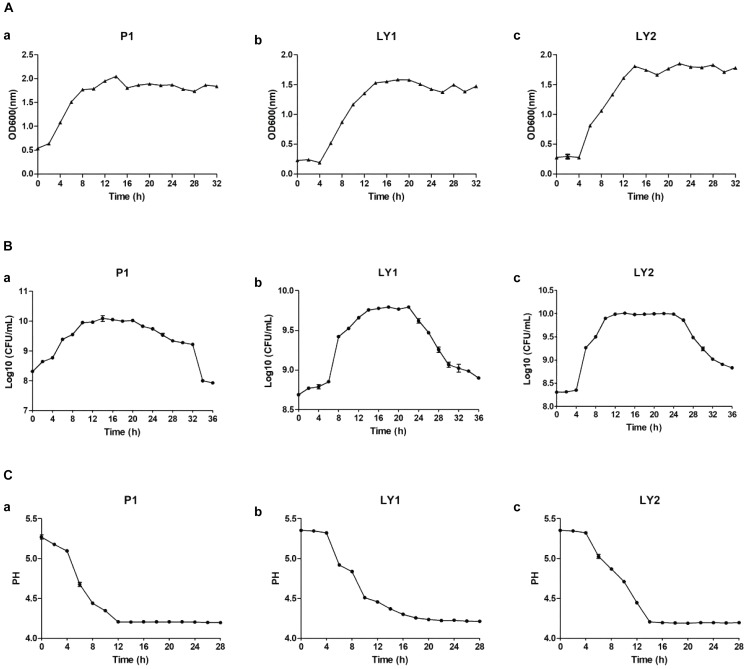
Measurement of OD600 values, colony-forming units and pH. (A) OD600 values measured every 2 h for a total of 32 h. (a) P1. (b) LY1. (c) LY2. (B) The colony-forming units were analyzed every 2 h for a total of 32 h, and the number of colonies was calculated as the log10 value of CFU per milliliter. (a) P1. (b) LY1. (c) LY2. (C) pH measurements taken every 2 h for a total of 26 h. (a) P1. (b) LY1. (c) LY2.